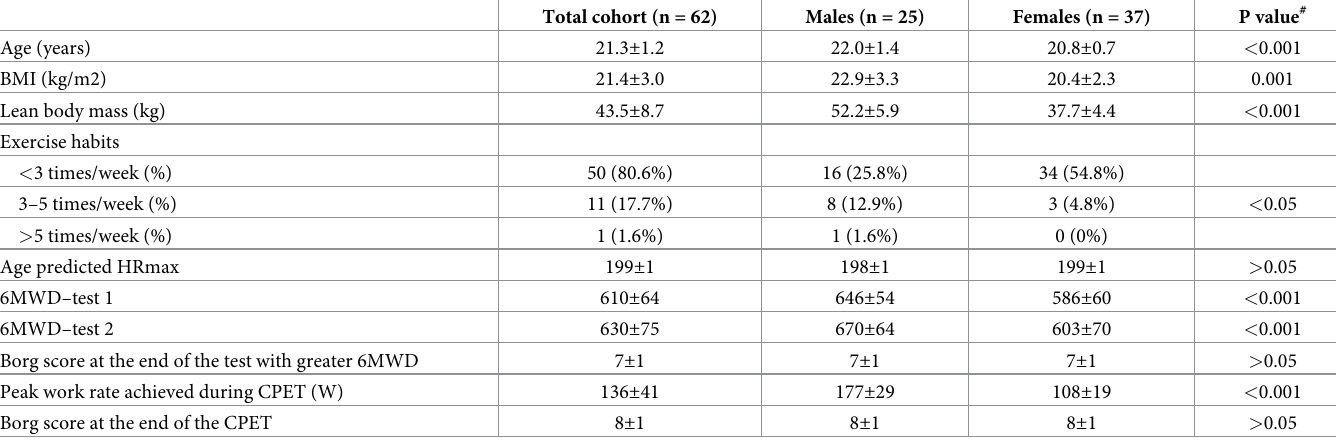
Table 1. Demographic data of the 62 participants. Data in mean ± SD unless annotated